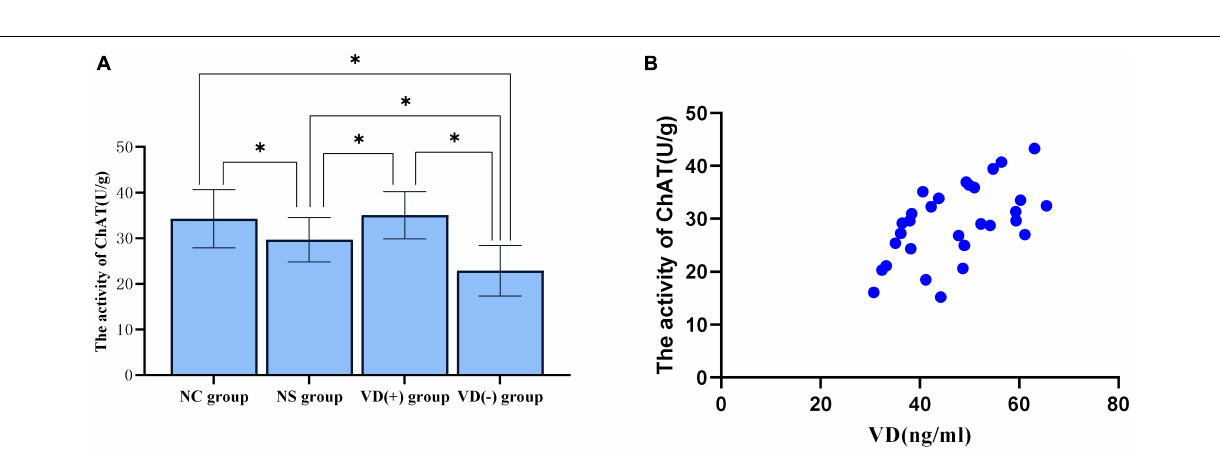
FIGURE 4 | Comparison of experimental results of spatial exploration. (A) Comparison of the times of crossing the platform: comparison with NC group: a P < 0.05; comparison with NS group: b P < 0.05. (B) Comparison of target quadrant activity time ratio: comparison between groups: ∗ P < 0.05.